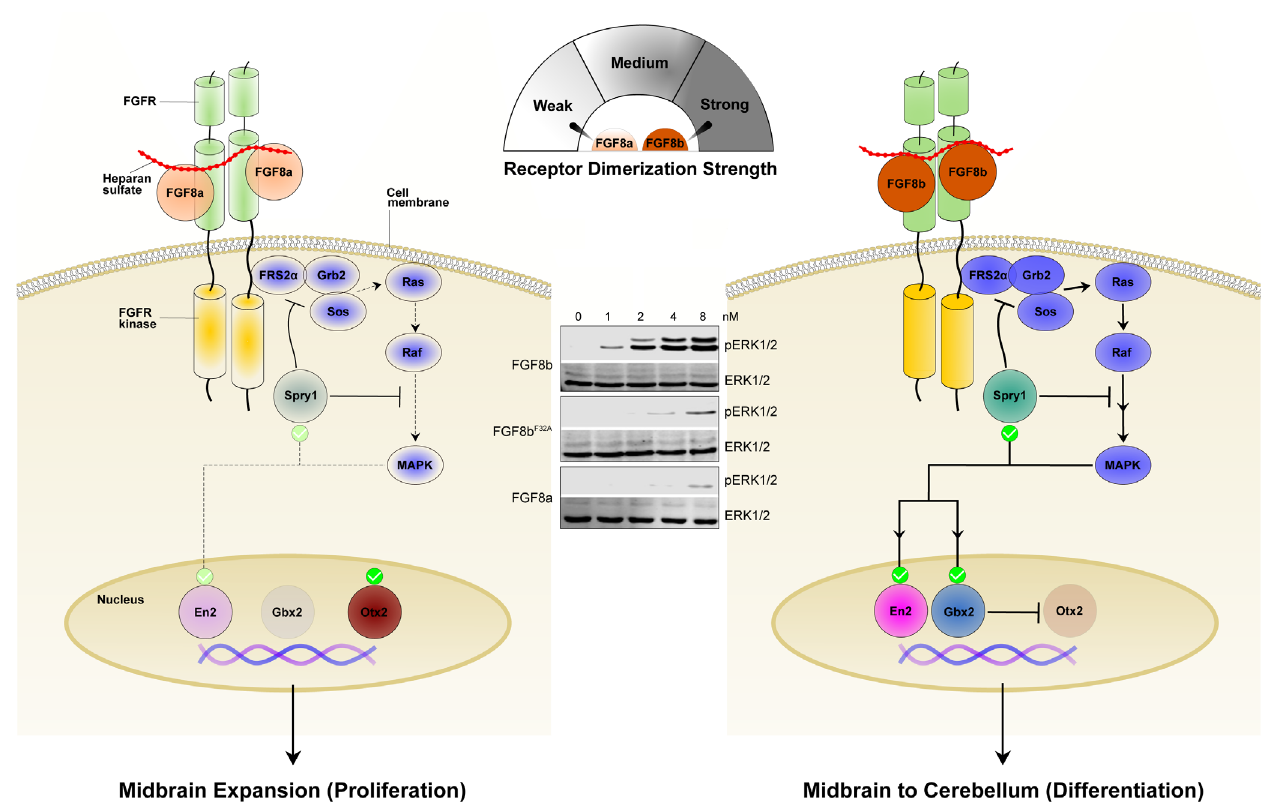
Figure 3. The “threshold model”, as exemplified by the FGF8-FGFR system, can explain disparities in transcriptional activity. (Left) FGF8a dimerizes its receptor weakly, thus transducing a transient signal that can only weakly induce En2 and Spry1 expression, while totally failing to induce expression of Gbx2, the Otx2 suppressor. In the absence of Gbx2, the expression of Otx2 remains high. Under these conditions, proliferation of midbrain is encouraged. (Center) Immunoblots previously published in Huang et al . 33 (2017) showing a dose-dependent activation of the MAPK pathway (ERK1/2) by FGF8a, FGF8b, and FGF8b F32A in the BaF3 cell line. By introducing the F32A mutation or reducing the FGF8b concentration, the MAPK activation appears similar to FGF8a. Data are representative of three independent experiments. (Right) FGF8b dimerizes its receptor strongly, thus producing a robust and persistent signal that strongly induces En2, Spry1, and Gbx2 expression, which suppresses Otx2 expression. Under these settings, midbrain differentiates to cerebellum. Thus, quantitative differences in the stability of FGF-induced FGFR dimers translate into differences in the magnitude/duration of the intracellular signal, which in turn modify the transcriptional landscape and ultimately define the developmental response. Stronger receptor dimerization strength and higher signaling intensity are indicated by darker coloring. FGF, fibroblast growth factor; FGFR, fibroblast growth factor receptor; MAPK, mitogen-activated protein